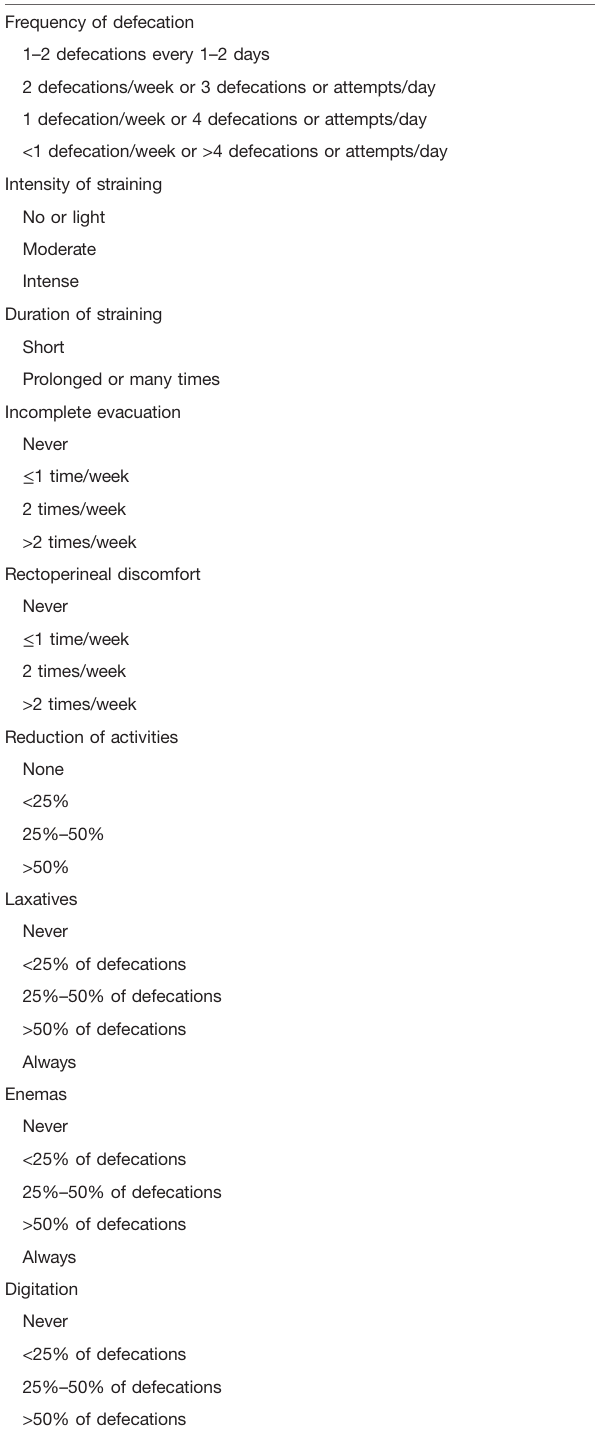
The bold values has Statistically signi fi cant P